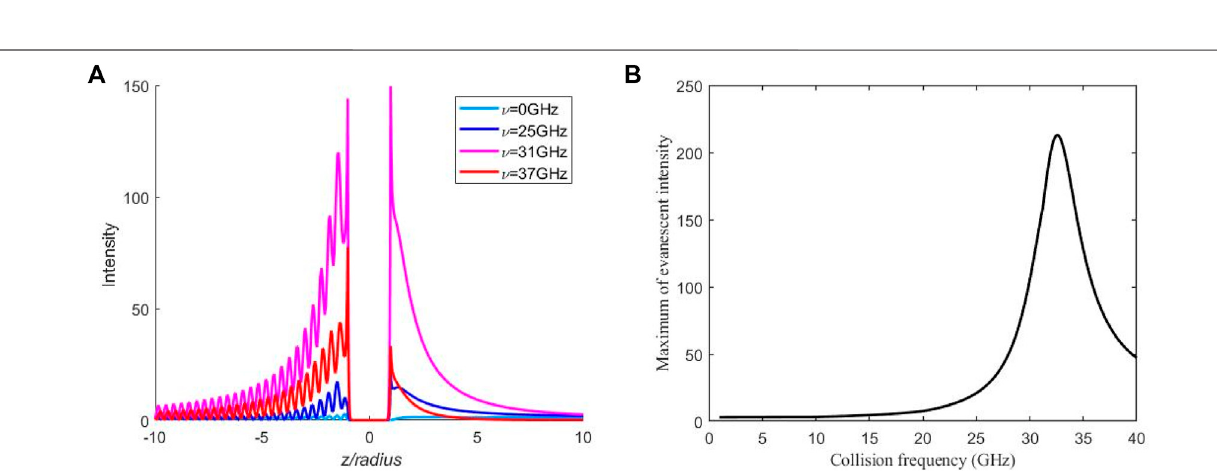
FIGURE 2 | The distribution of internal and near fi elds for a plasma sphere with f i = 2.1 GHz, f p = 9 GHz, ] c = 29 GHz. (A) The three-dimensional intensity pattern and (B) the intensity distribution along the z -axis.